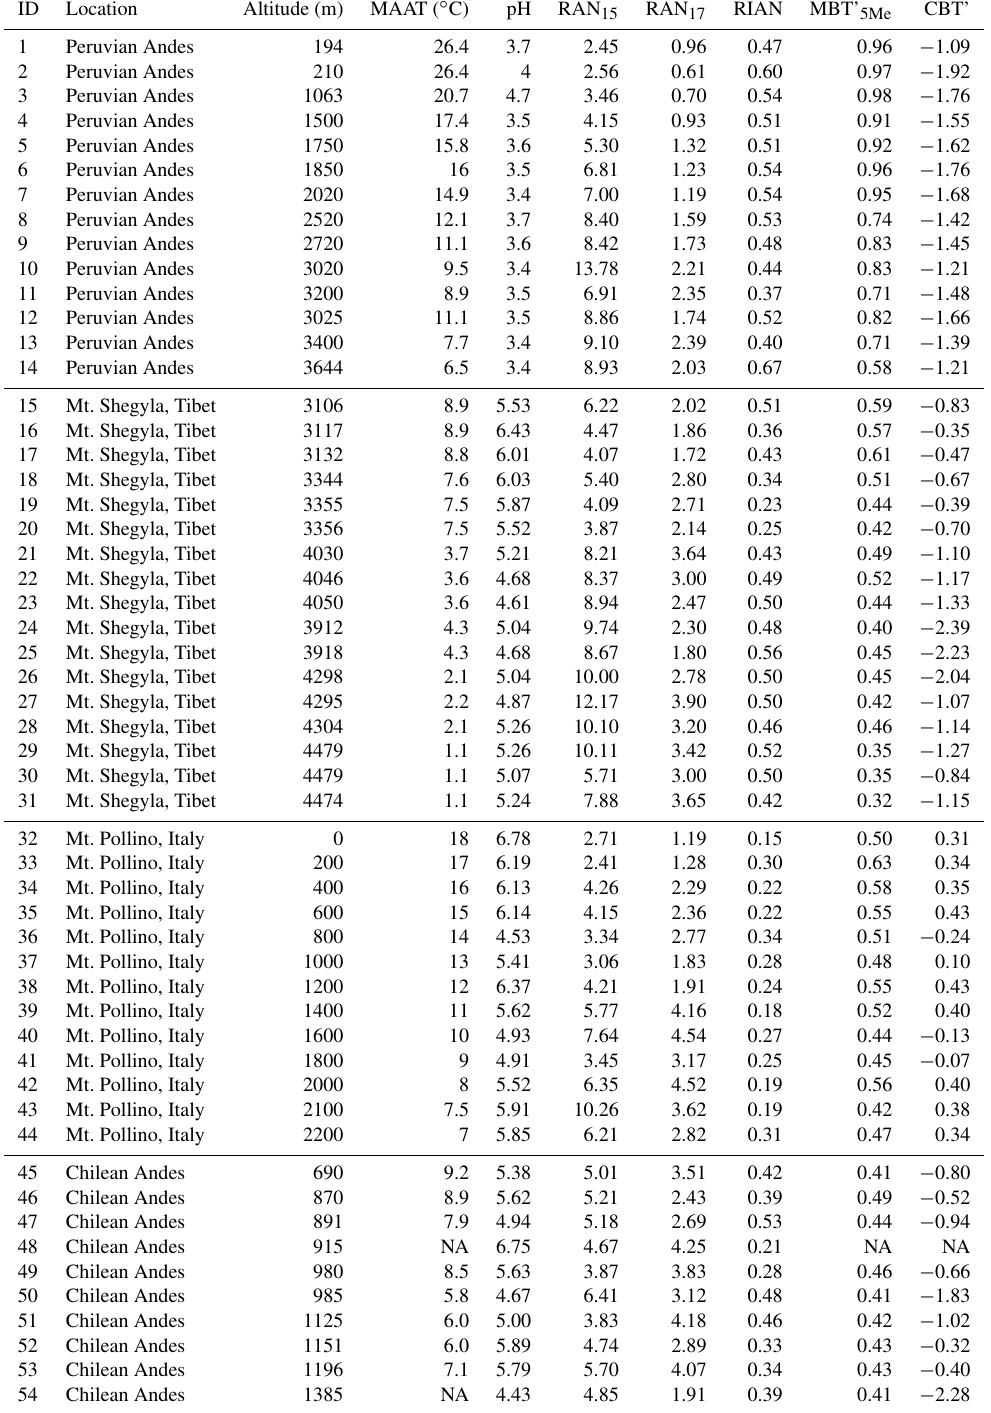
Table 1. List of the soil samples collected along Mt. Shegyla, Mt. Pollino, the Peruvian Andes and the Chilean Andes, with corresponding altitude (m), MAAT ( ◦ C), pH, and 3-OH-FA- and brGDGT-derived